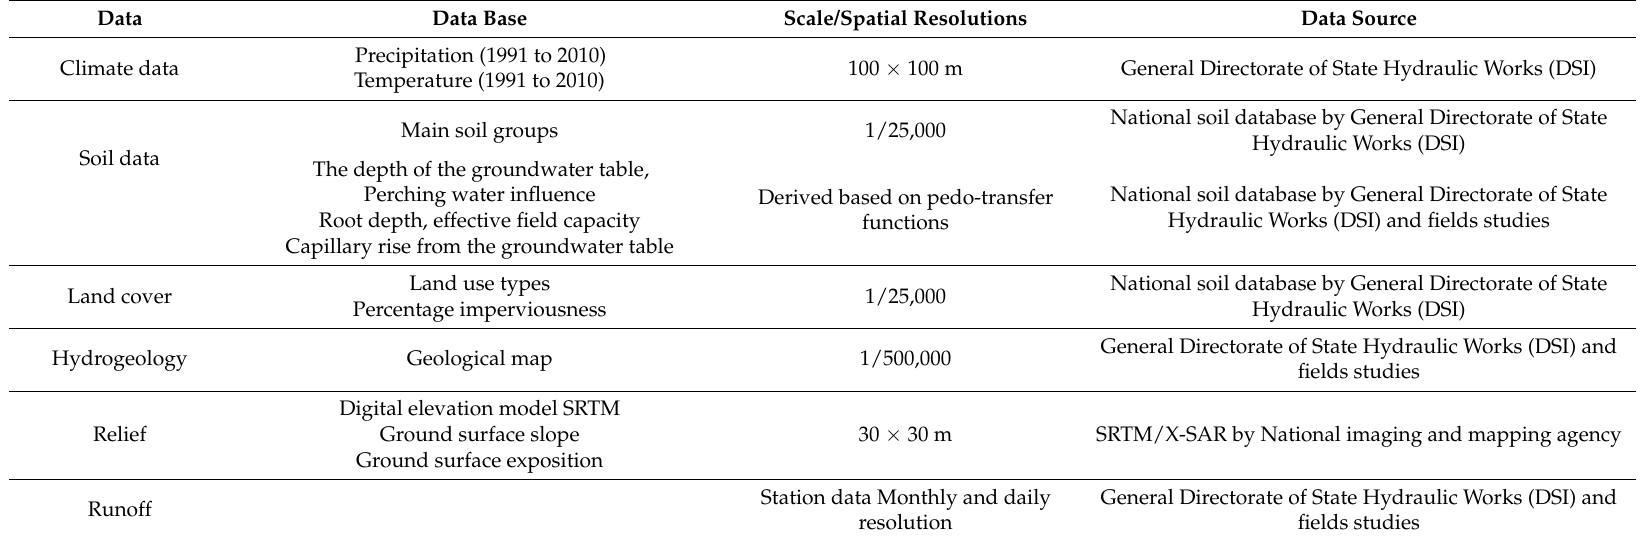
Table 3. Database of the mGROWA water balance model for the Ergene